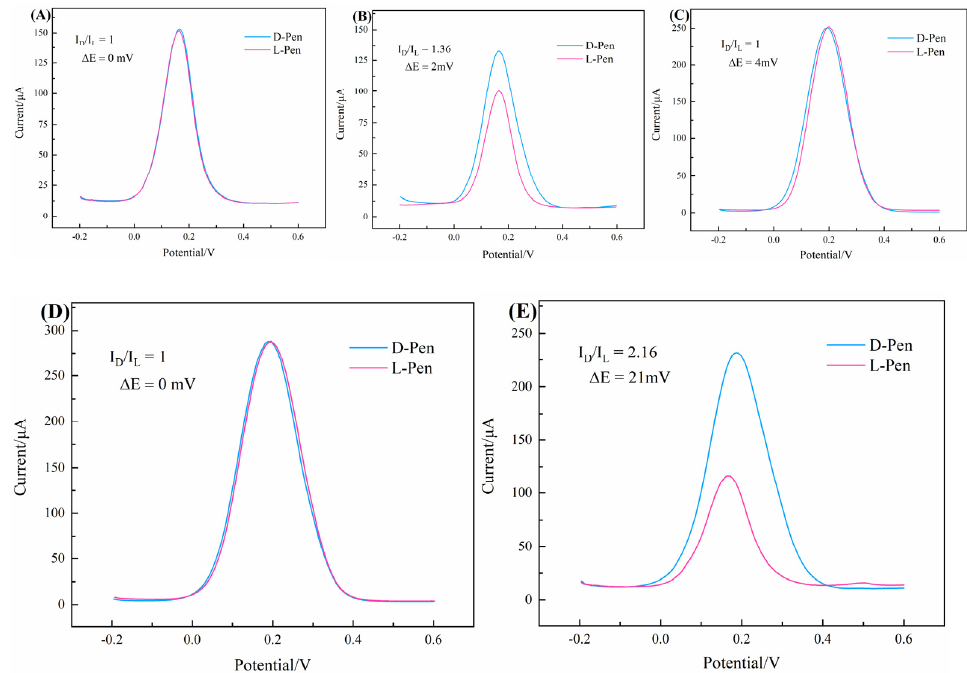
Figure 6. DPV curves of 5 mM L-Pen or D-Pen at the bare GCE ( A ), SCS/GCE ( B ), PAA- MWCNTs/GCE ( C ), PAA-MWCNTs-Ag/GCE ( D ), and PAA-MWCNTs-Ag-SCS/GCE ( E ) were recorded in 0.1 M KCl containing 5 mM [Fe(CN) 6 ] 4 − /3 − , respectively.